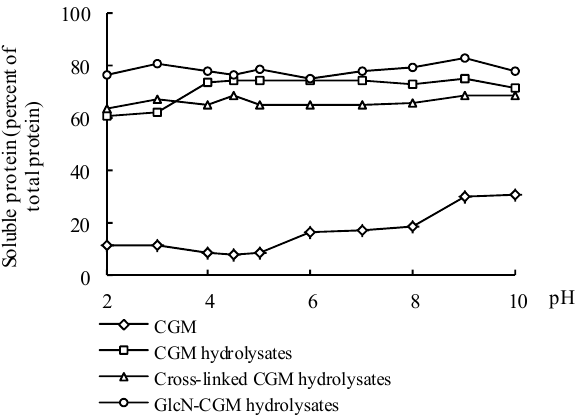
Figure 6. Solubility–pH profiles of CGM, CGM hydrolysates, cross-linked CGM hydrolysates and GlcN-CGM hydrolysates.